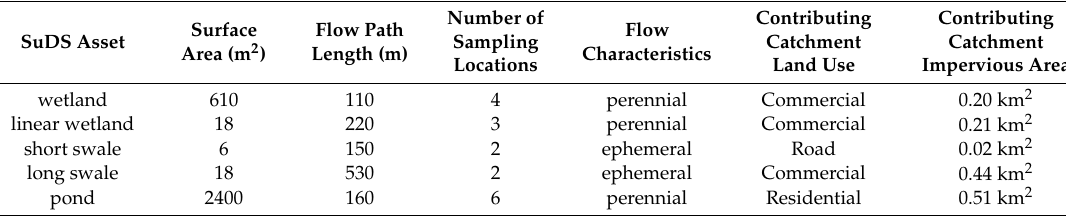
Table 1. Summary of monitored SuDS